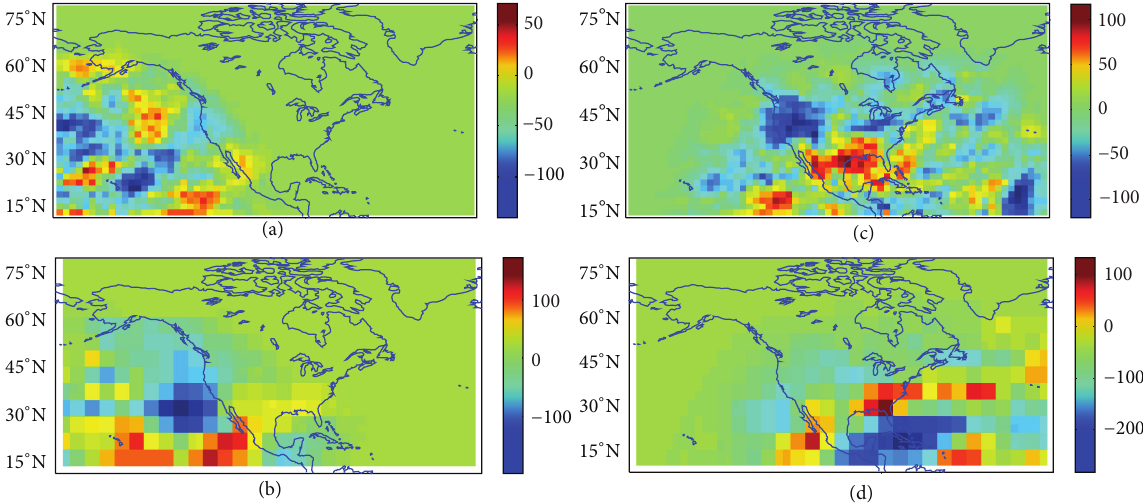
Figure 8: (a) The trend of downward shortwave radiation at surface at 3 p.m. local time of US West Coast, defined in the same manner as Figure 6(c) but for the average over January, from GFDL CM2.0 simulations. (b) The same as (a) but from MRI CGCM2.3.2 simulations. Panels (c) and (d) are the counterparts of (a) and (b) but for 9 a.m. local time of US West Coast, also averaged over January. The trends in all four panels are defined as January 2100 average minus January 2000 average. The color scale with units of W/m 2 is shown on the right for each